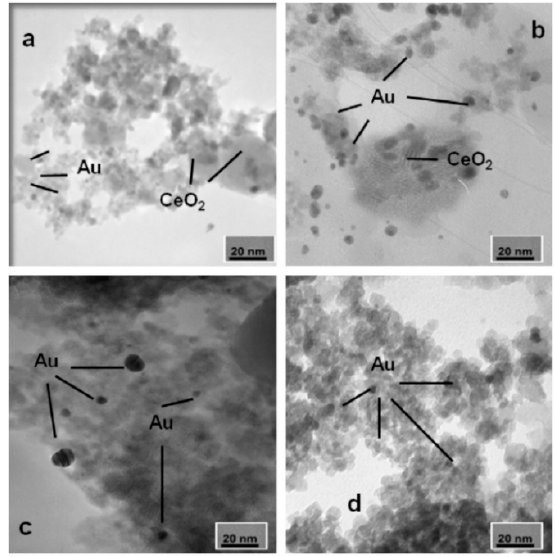
Figure 6. TEM of Au on different supports: ( a ) Au/CeO 2 ; ( b ) Au/Ce 7.5 /Al 2 O 3 ; ( c ) Au/Al 2 O 3 ; ( d ) Au/TiO 2 [121].